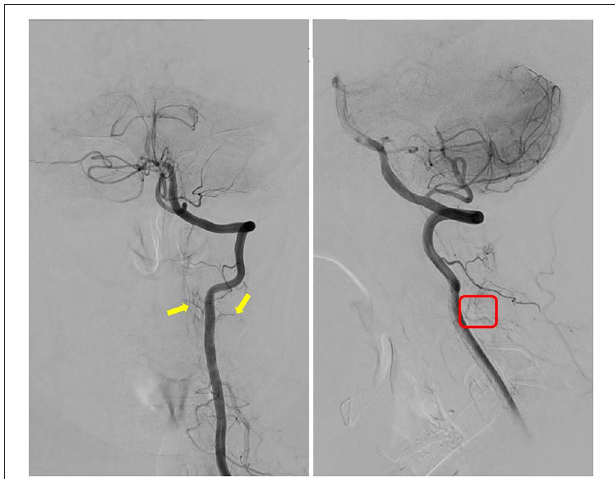
FIGURE 3 | Follow-up spinal digital subtraction angiography (DSA) demonstrated images of L-VA; the yellow arrows indicate that the two supplying arteries no longer feed into the arteriovenous fistula (AVF); and red box indicates that tortuous venous drainage of the AVF had disappeared as compared with pre-op DSA image.